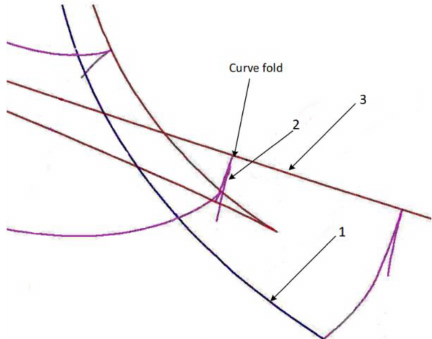
Figure 7. Tooth profile produces prismatic phenomenon. 1 – Pitch curve. 2 – Right tooth profile curve. 3 – Spherical base curve of right tooth